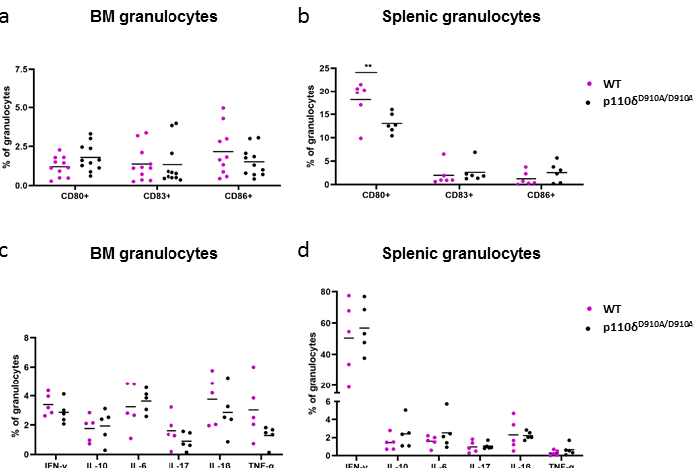
Figure 4. ( a , b ) Flow cytometry analysis of neutrophil activation markers; p110δ D910A/D910A mice (black dots) were compared to their respective WT littermates (purple dots). Neutrophils isolated from bone marrow ( a ) and spleen ( b ) were analysed for their expressions of CD80, CD83 and CD86. ( c , d ) Flow cytometry analysis of ex vivo stimulation of cells and intracellular cytokine staining; p110δ D910A/D910A mice (black dots) were compared to their respective WT littermates (purple dots). Neutrophils isolated from bone marrow ( c ) and spleen ( d ) were analysed for their intracellular lev- els of IFN- ɣ , IL-10, IL-6, IL-17, IL- 1β and TNF - α. The grap hs are expressed as percentage of granu- locytes synthesizing each cytokine. Statistical significance was determined by two-way ANOVA